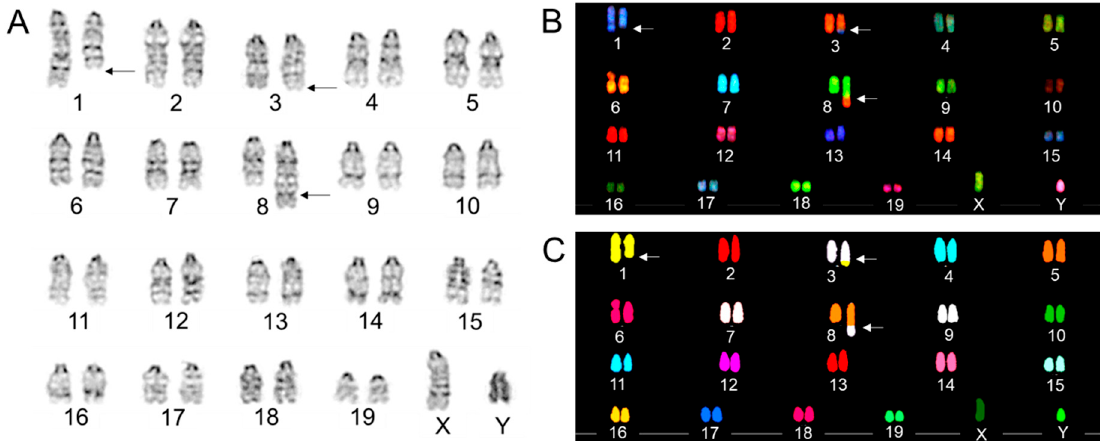
Figure 1. ( A ) A representative G-band karyogram of a RAW 264.7 cell showing 40 chromosomes. Arrows indicate rearrangements, additions, and deletions. Representative ( B ) spectral and ( C ) classified images of a RAW 264.7 cell showing 40 chromosomes. Arrows indicate rearrangements, additions, and deletions.